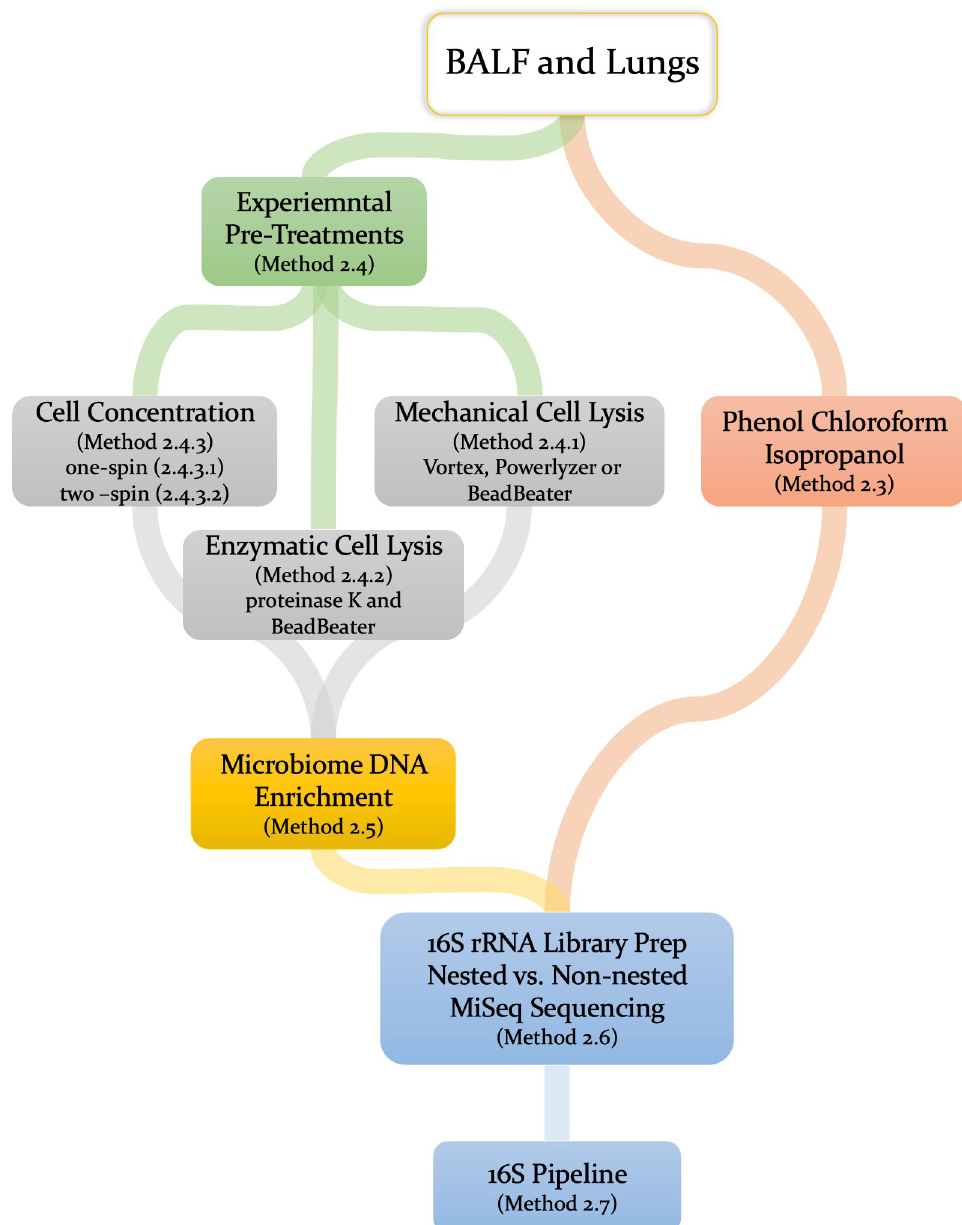
Fig 1. Workflow for processing BALF and lung samples for microbiome data. Initially we compared two DNA extraction methods (experimental kit-based and PCI) and three forms of sample pre-treatment method. A small subset of samples was used to compare the efficiency of Microbial Enrichment kit. The V4 16S region was selected for preparing two nested (25x25 and 35x25 PCR cycles) and one non-nested (35 PCR cycles) libraries preparation